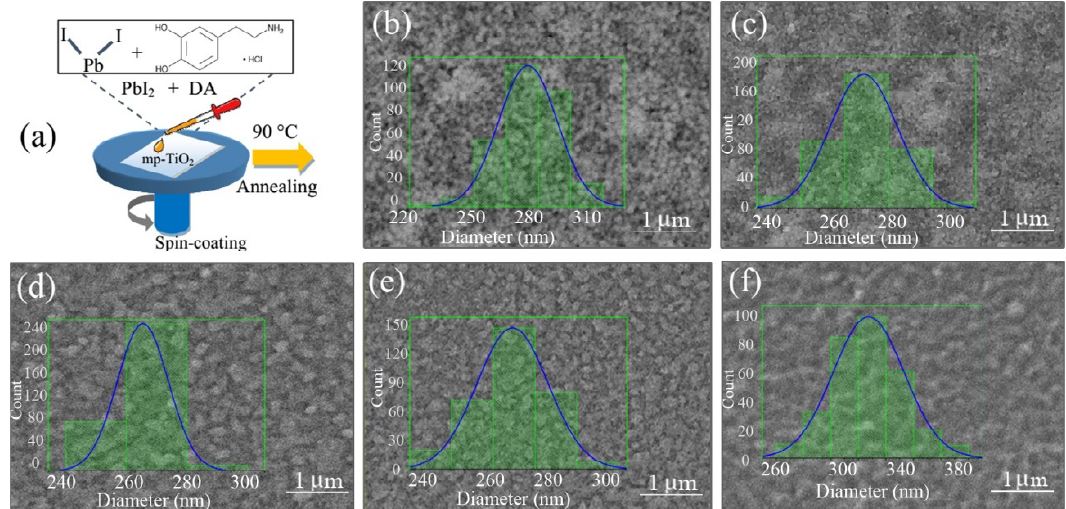
Fig. 1. (a) Schematic procedure for the preparation of PbI 2 film with DA additive. Surface SEM images with histogram of particle size for PbI 2 films deposited on the mp-TiO 2 with or without DA linker in PbI 2 procedure; (b) without DA; (c) 0.2 wt% DA; (d) 0.4 wt% DA; (e) 0.6 wt% DA; (f) 0.8wt% DA